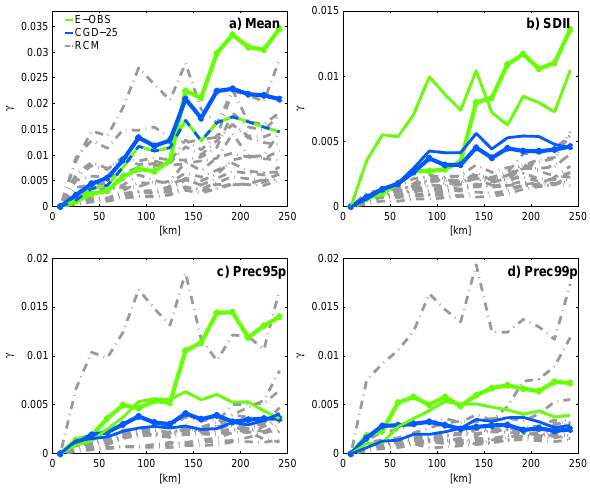
Fig. 7. Semivariograms for E-OBS, CGD-25 and all the RCMs. The RCMs with the minimum RMSE estimated using E-OBS and CGD- 25 are highlighted in green and in blue, respectively.